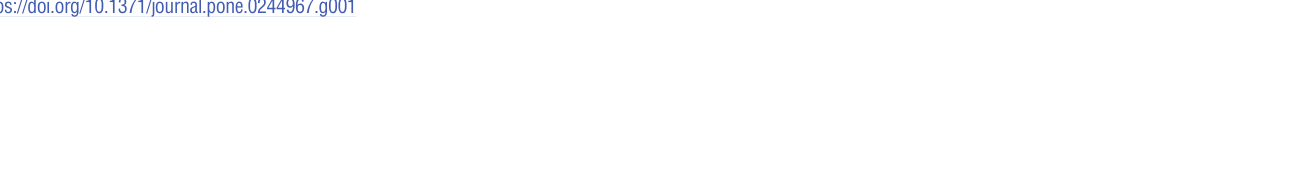
PLOS ONE | https://doi.org/10.1371/journal.pone.0244967 January 15, 2021 3 /